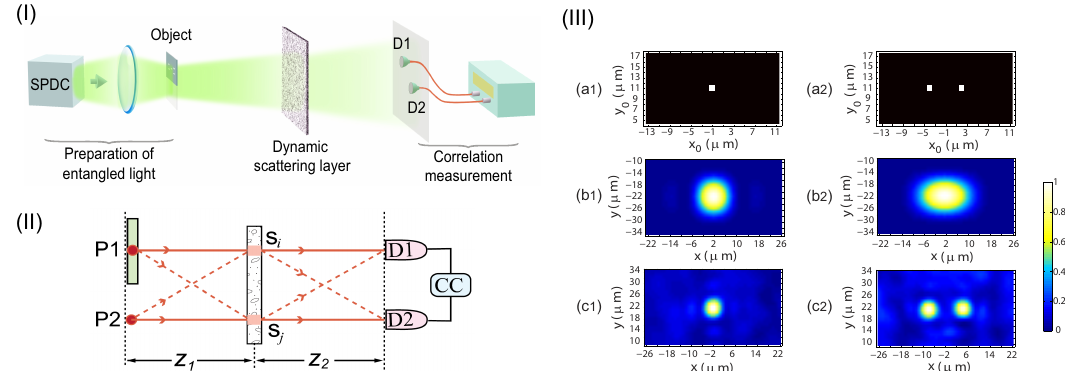
Figure 8. ( I ): Schematic of the super-resolution imaging scheme assisted by a dynamic scattering layer. The object is placed on the top half of the Fourier plane of the output plane of the entangled source, while the bottom half of the Fourier plane is kept transparent. For achieving super-resolution image of an amplitude object, an additional dynamic scattering layer should be placed near the object, or directly on the bottom half of the Fourier plane. ( II ): Different but indistinguishable two-photon paths in the imaging scheme. Constructive two-photon interference employed by the scattering layer can be observed by scanning the two single-photon detectors D1 and D2. ( III ): HL super-resolution images ( c1 , c2 ) for single point object ( a1 ) and two point objects ( a2 ), respectively. The super-resolution effect is demonstrated by comparing with the intensity images ( b1 , b2 ) of the two objects obtained through conventional lens-assisted single-photon imaging. The figure is reproduced with permissions from Ref. [40] of